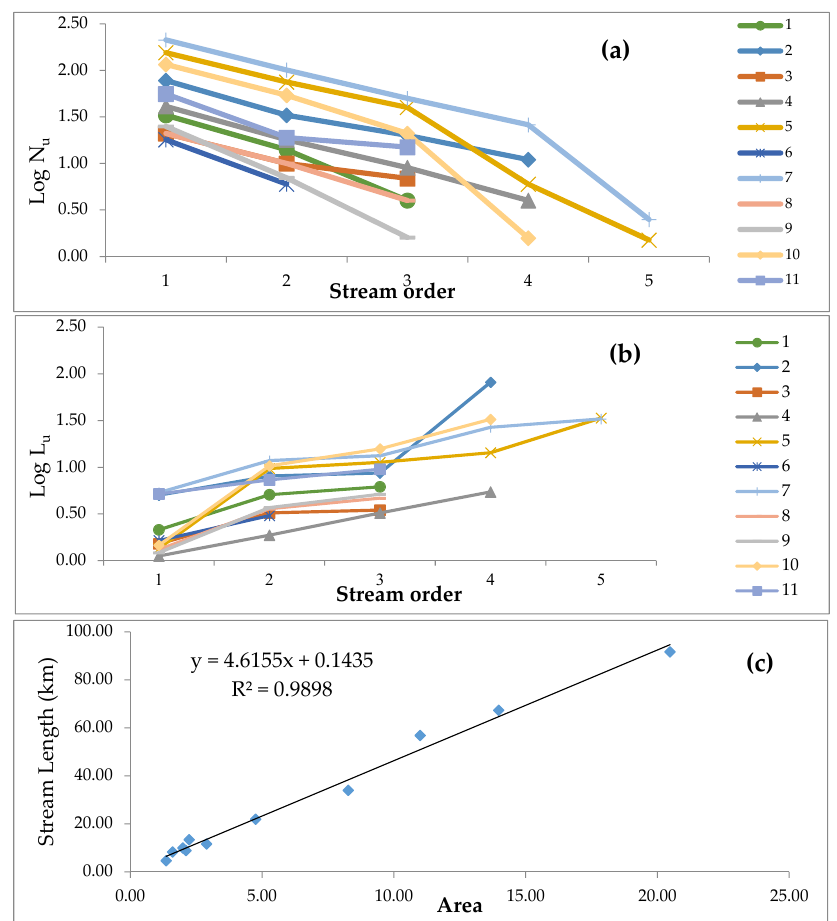
Figure 6. Stream order in the Kalv ā r ī basin.